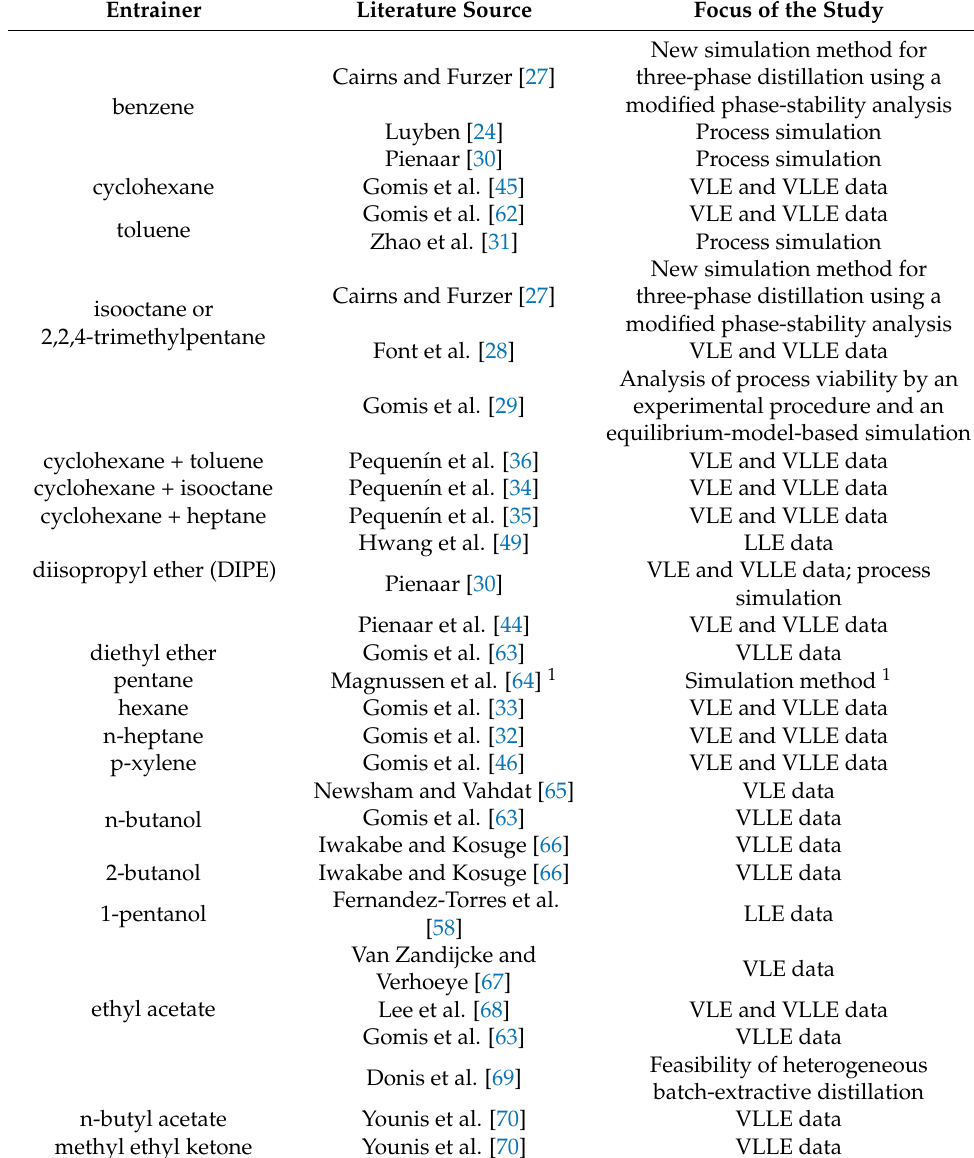
Table 1. List of entrainers considered in the literature for the dehydration of ethanol.